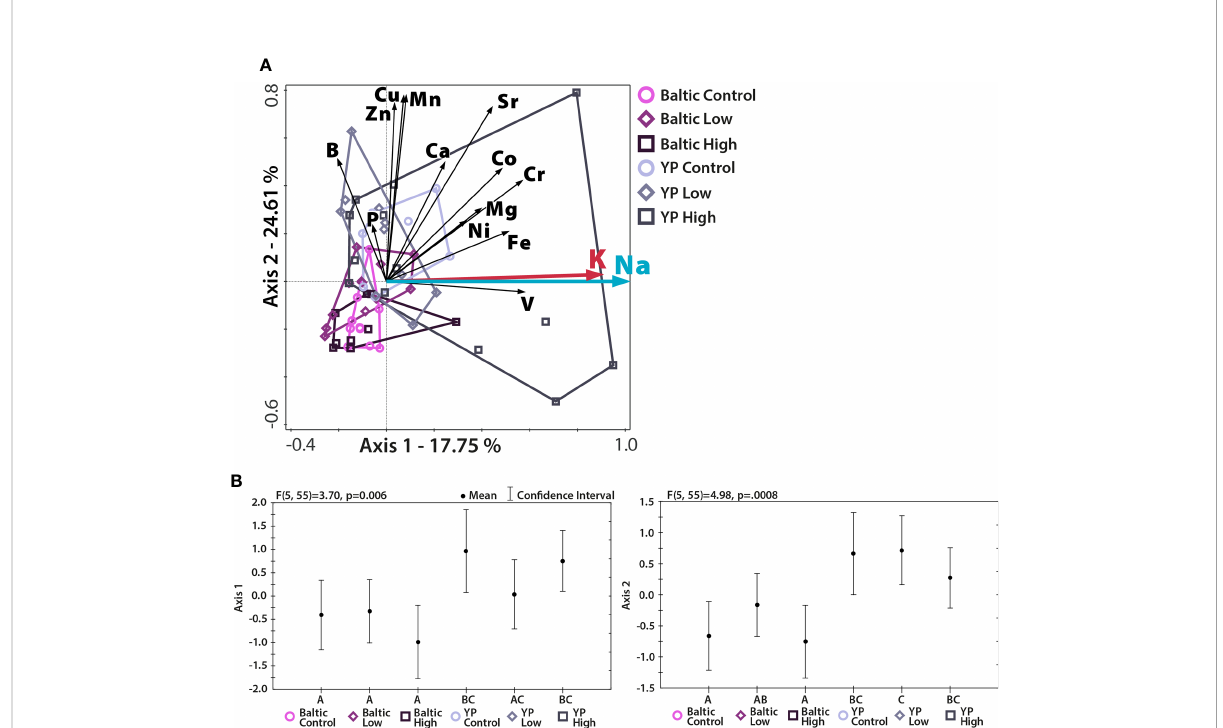
FIGURE 1 Multivariate analysis (RDA) of the relationships between the studied element concentrations and the proportion of Na in the studied pollen. N = 61, p = 0.002; (A) RDA plot, with the fi rst two axes presented. The percentage of variation explained is given for both axes. The lengths of the vectors represent the contributions of the elements to the pattern shown (longer vector=greater contribution). The direction of the vector shows the axis to which it contributes. (B) ANOVA performed for both axis scores; different letters denote signi fi cant differences between the studied pollen groups. Different cultivars, but not Na treatments, were separated from each other. The addition of NaCl to soil increased the variation in concentrations of measured elements in